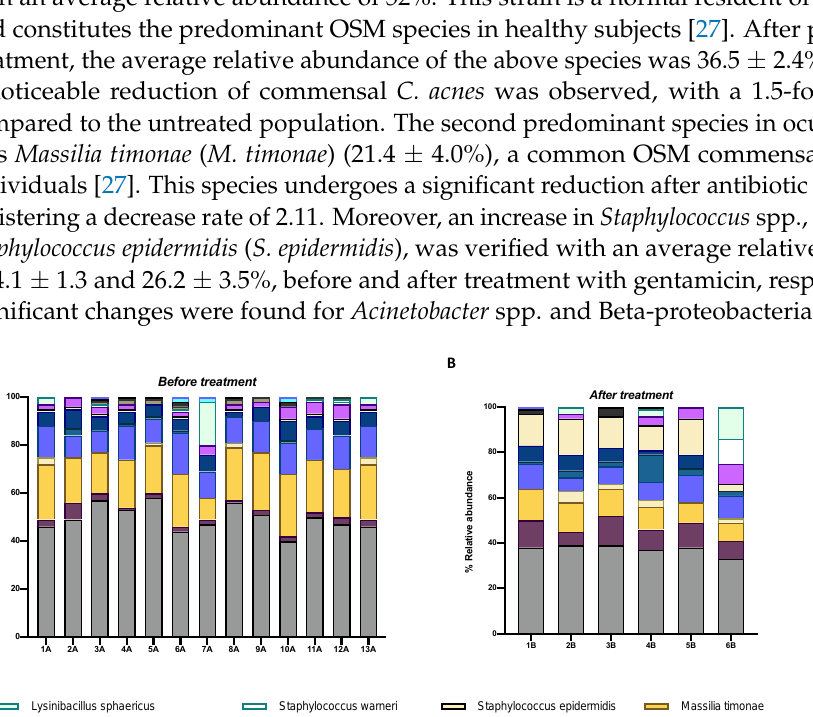
Figure 2. Distribution of relative genera abundance in conjunctival swabs before ( A ) and after ( B ) prophylaxis with gentamicin ( p -value < 0.0001).